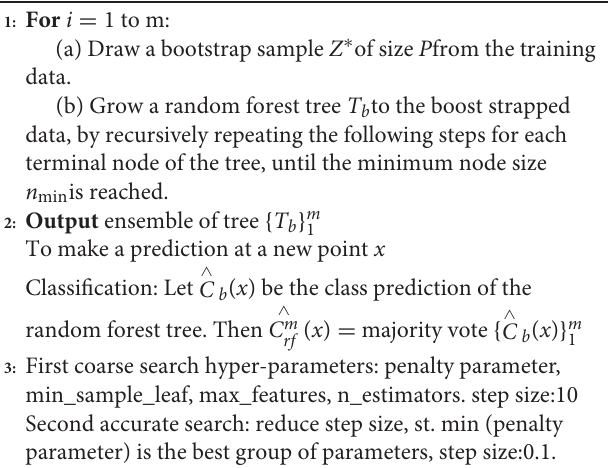
Algorithm 2: Random Forest for Classification. ( RF , Z i